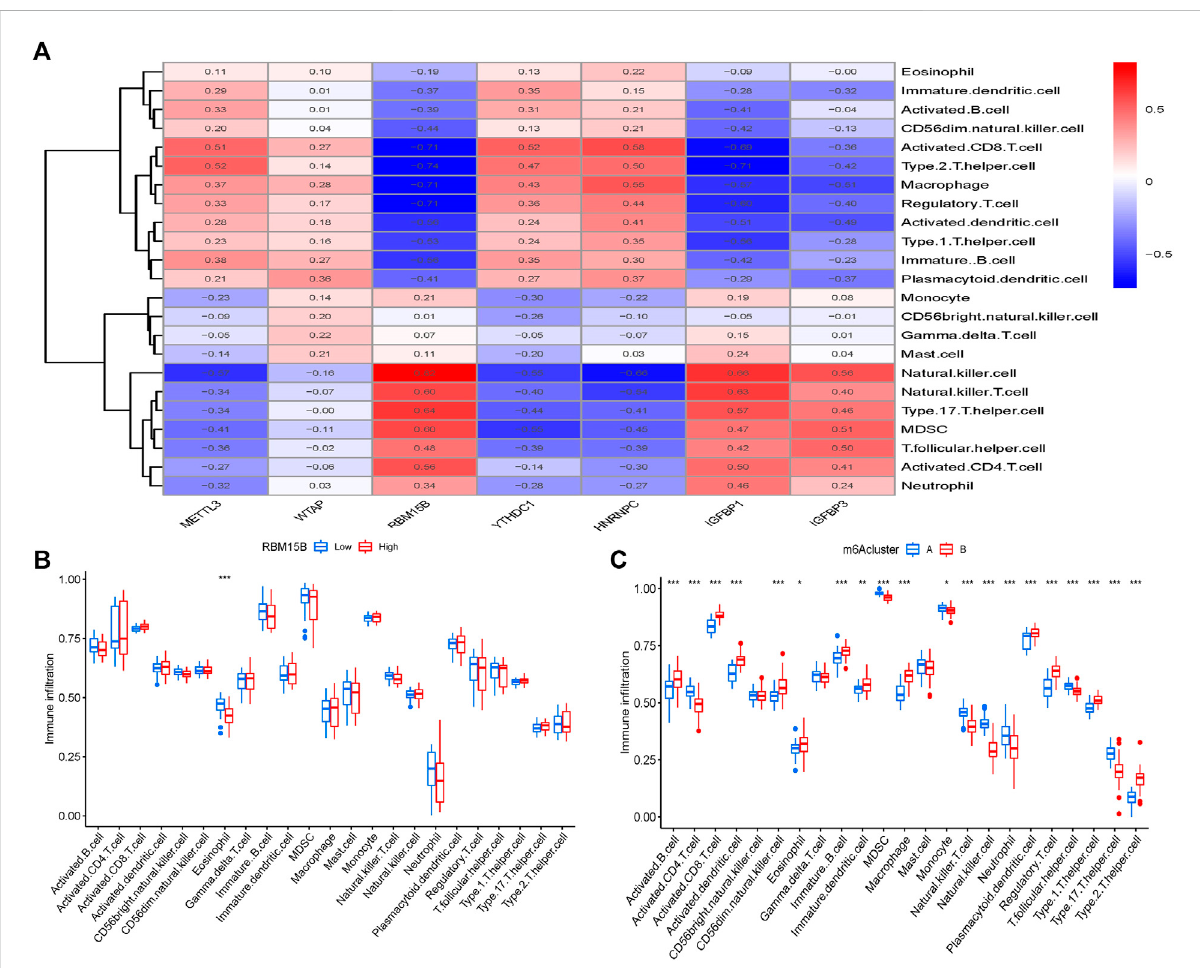
FIGURE 7 Gene collection from a single sample and enrichment analysis. (A) Correlation between immune cells and seven key m 6 A modulators found in different species. (B) Differences in the number of in fi ltrative immune cells between groups with lower and higher RBM15B expression. (C) Immune cell in fi ltration differences between clusters A and B. * p < 0.05, ** p < 0.01, and *** p <